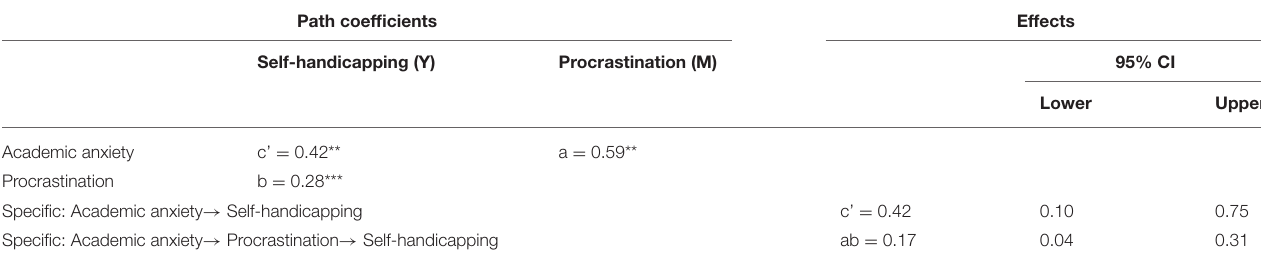
TABLE 3 | Path coefficients for mediation model.